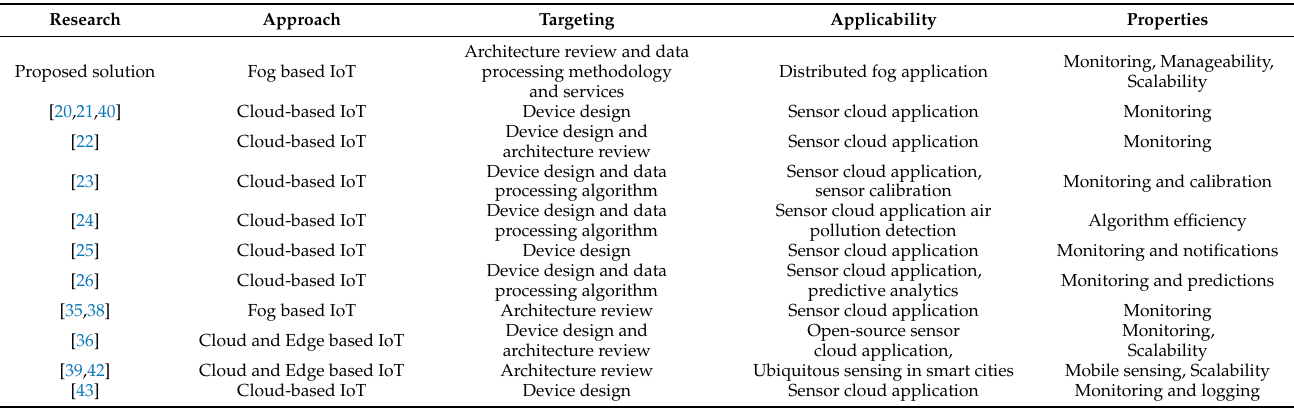
Table 1. A summarized review of recent studies regarding the design, analysis and implementation of AQM methodology and architectures.